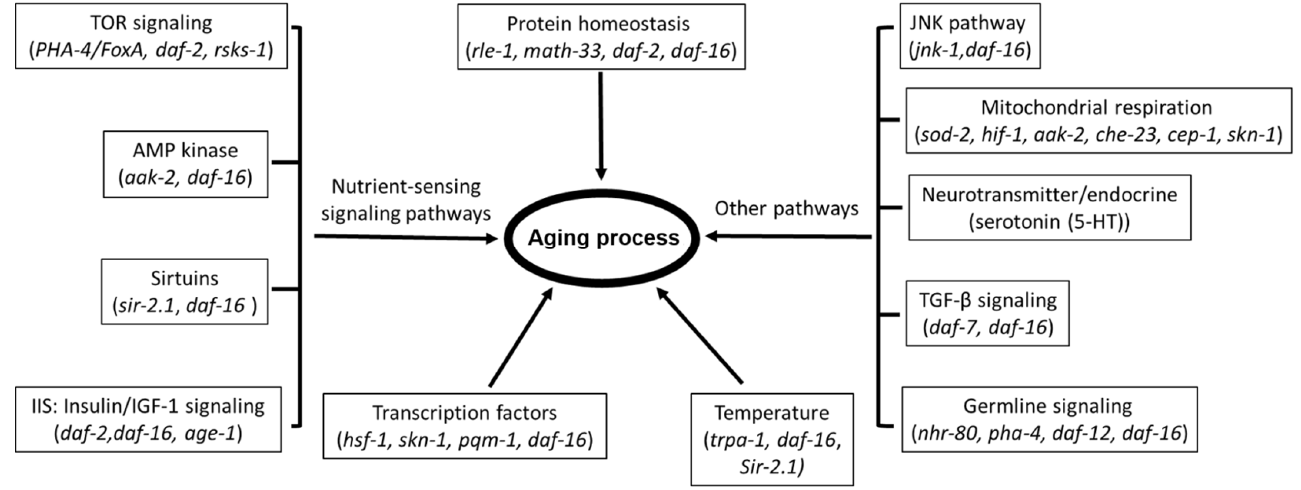
Figure 1. The known signaling pathways and key factors linked to aging